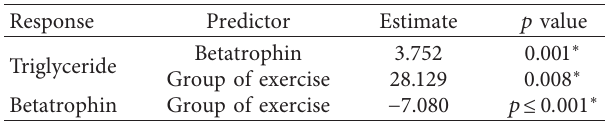
Table 4: Test for confounding effect using univariate and multi- variate regression